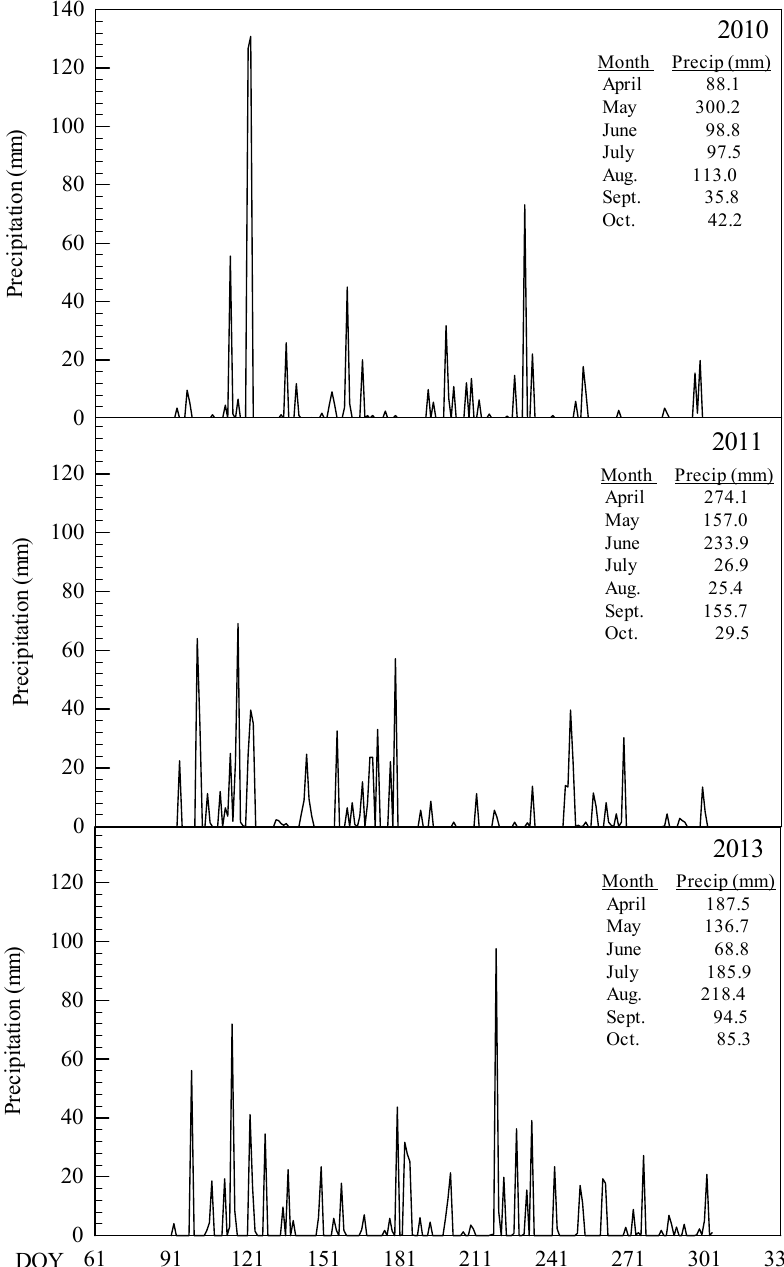
Figure 1. Daily precipitation during the growing seasons of 2010, 2011 and 2013. DOY, day of